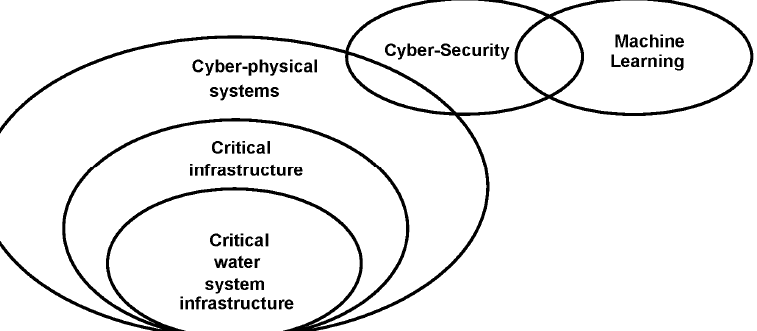
Figure 1. Illustration of connectedness between machine learning and cybersecurity in critical water system infrastructure [8].